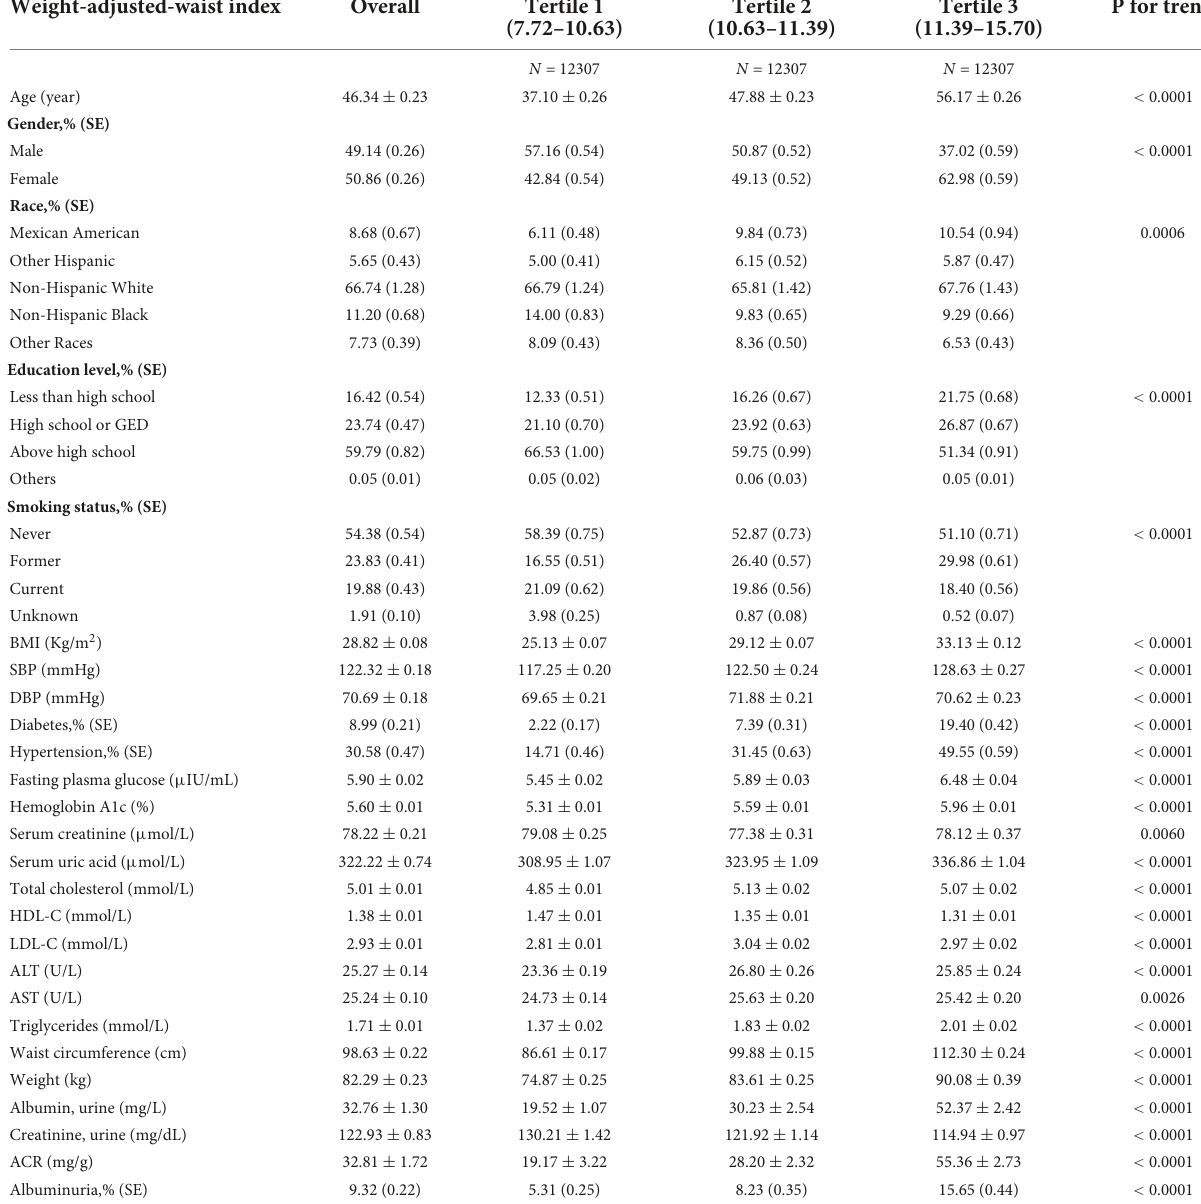
TABLE 1 Baseline characteristics of study population according to weight-adjusted-waist index tertiles. Weight-adjusted-waist